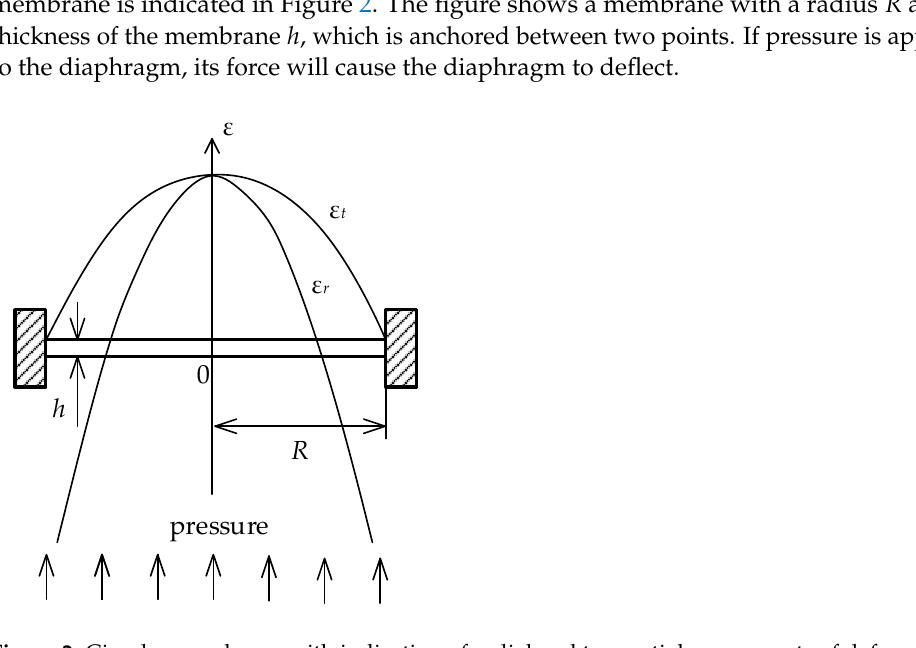
Figure 2. Circular membrane with indication of radial and tangential components of deformation caused by